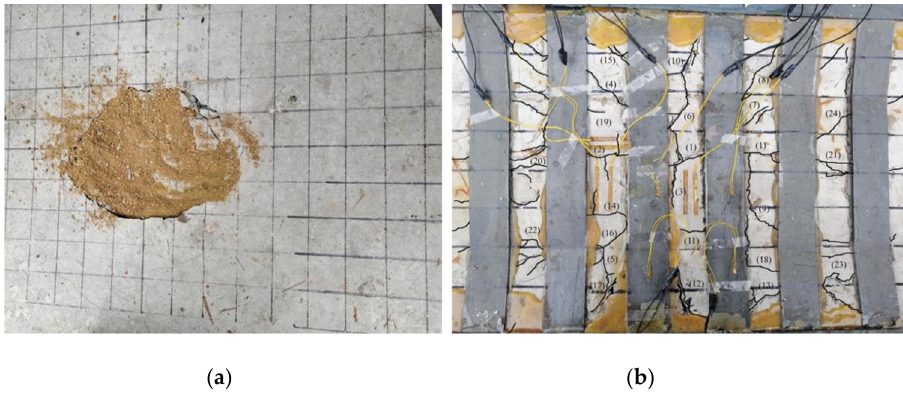
( b ) Damage to lower part of bridge deck. Damage to lower part of bridge deck. Figure 11. Fatigue test failure of PL4 test beam ( a ) Damage to upper part of bridge deck and ( b )